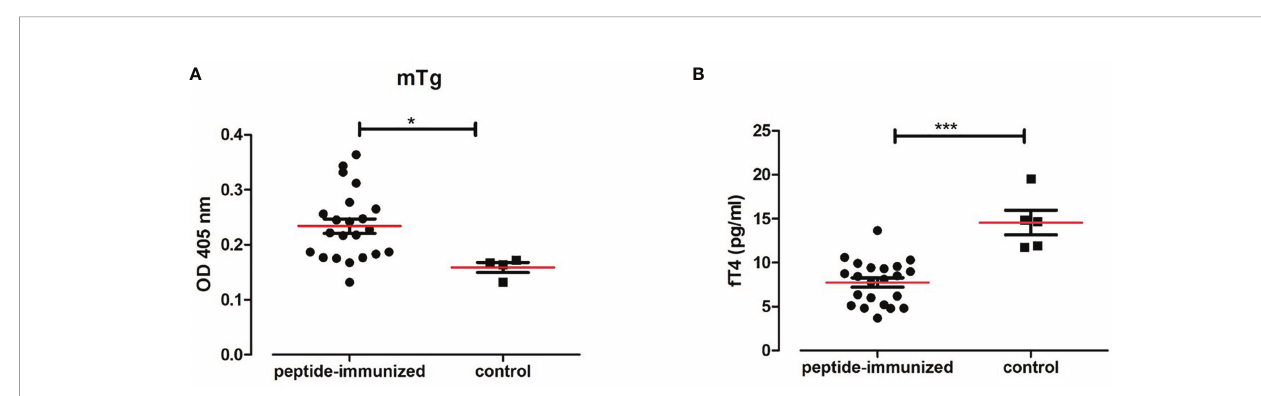
FIGURE 7 | Twenty-two humanized NOD-DR3 mice were co-immunized with Tg.1571, GAD.492 and TPO.758. Figure 7 shows the humoral response and thyroid functions in humanized NOD-DR3 mice co-immunized with Tg.1571, GAD.492 and TPO.758. Autoantibody response to mouse Tg (A) and free T4 levels (B) of humanized NOD-DR3 mice co-immunized with the three thyroid and islet peptides, compared to control mice immunized with PBS and adjuvant. * p < 0.05; *** p <